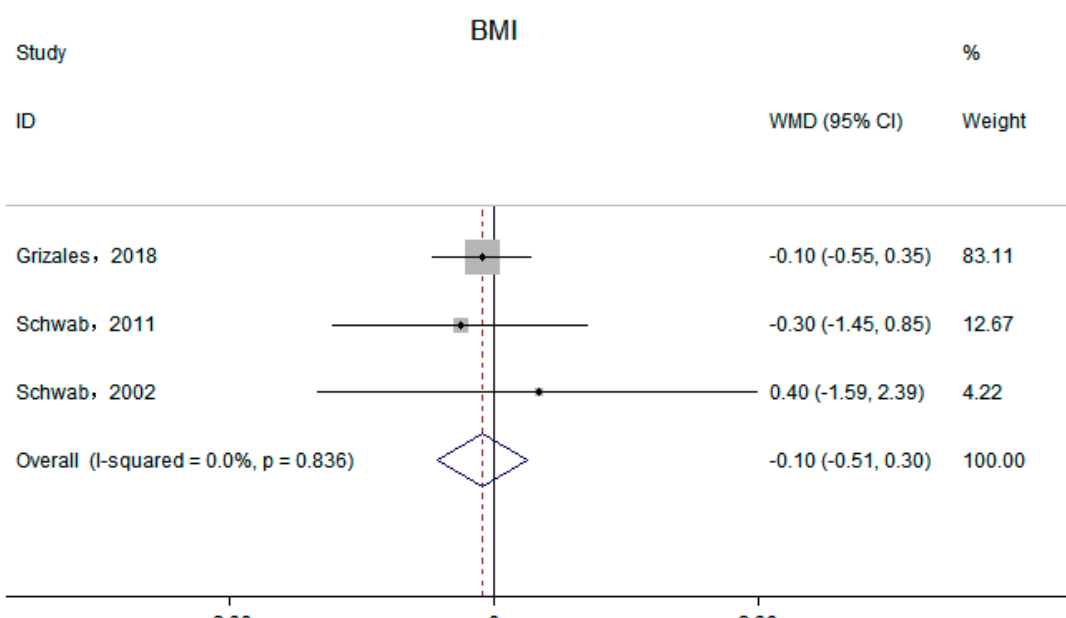
Figure 3. Effects of supplemental betaine on BMI in participants. The pooled effect was calculated by using a random-effects model. The diamonds denote the summary risk estimate, and the horizontal lines represent the 95% CI.